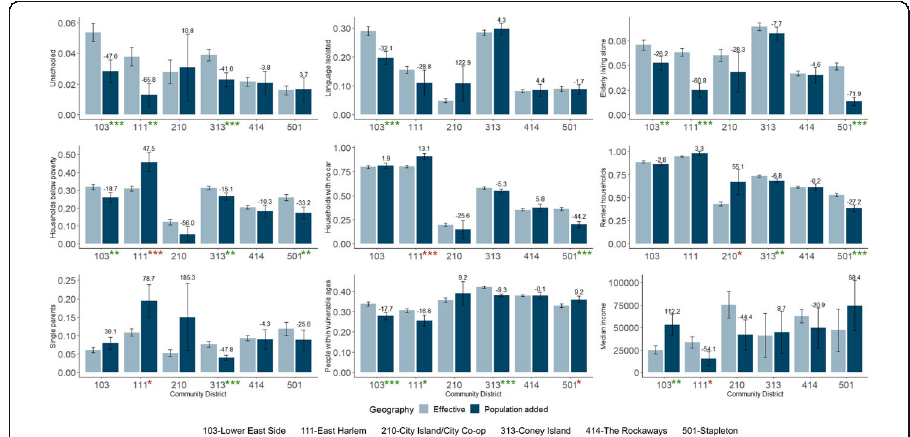
Fig. 7 Differences between the exposed populations according to the effective SFHA and those added due to its redrawing. Error bars represent the Standard Error of those variables that correspond to ACS estimates, and asterisks indicate the statistical significance of the measures compared according to p-values below 0.01 (***), 0.05 (**) and 0.1 (*). No asterisks mean that there is no statistically significant difference. Red asterisks indicate that the added population is more vulnerable, while green asterisks indicate lower